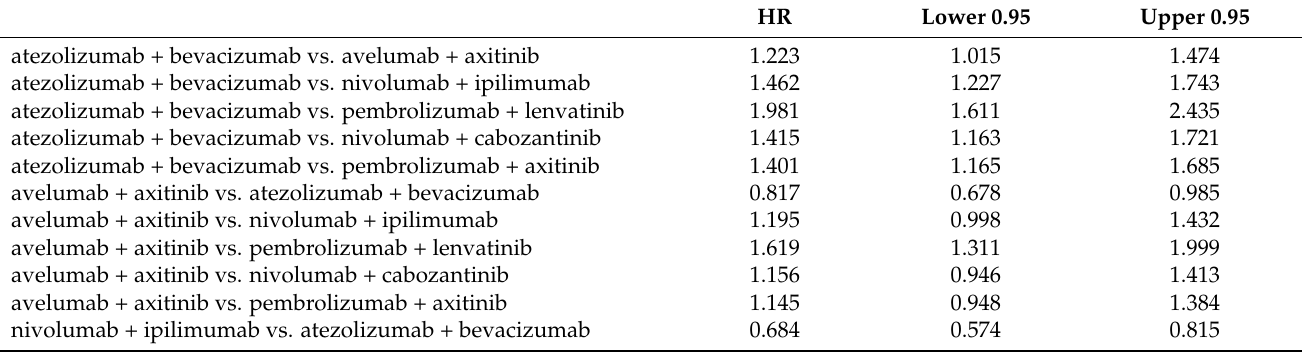
Table 2. Results of statistical analysis of indirect treatment comparison of PFS between combina- tion